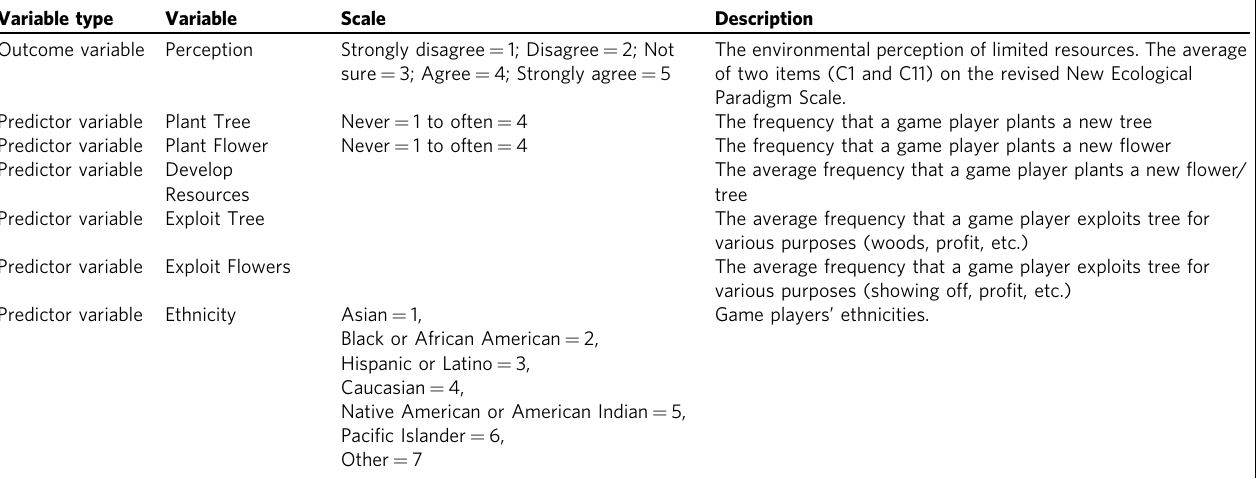
Table 2 Outcome and predictor